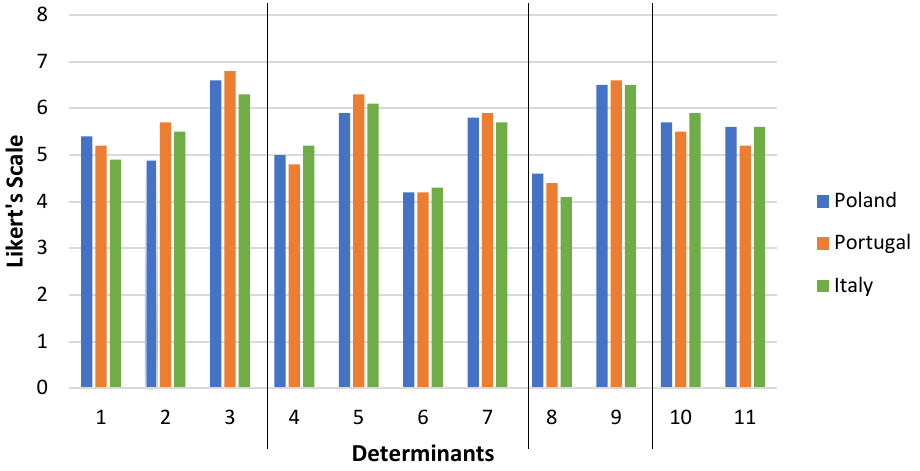
Figure 4. Aggregated results for the SERVPERF method.